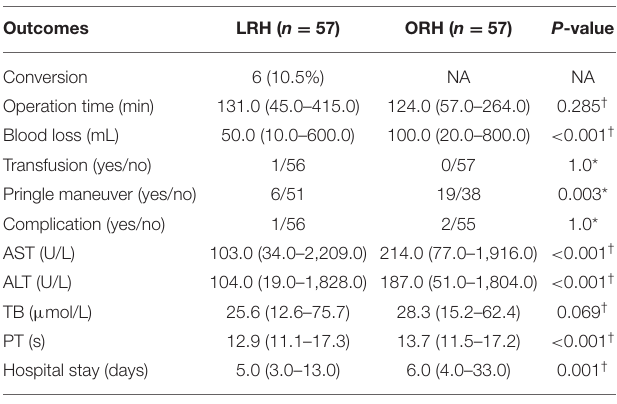
TABLE 2 | Surgical outcomes after